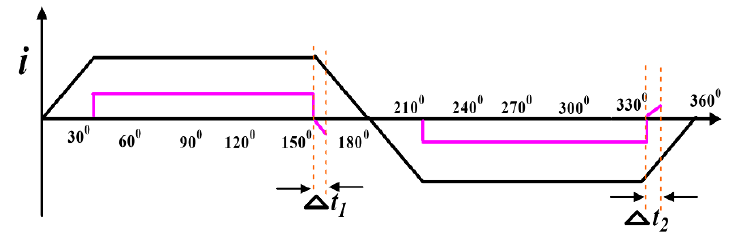
Figure 4. Freewheeling phase current after the commutation.